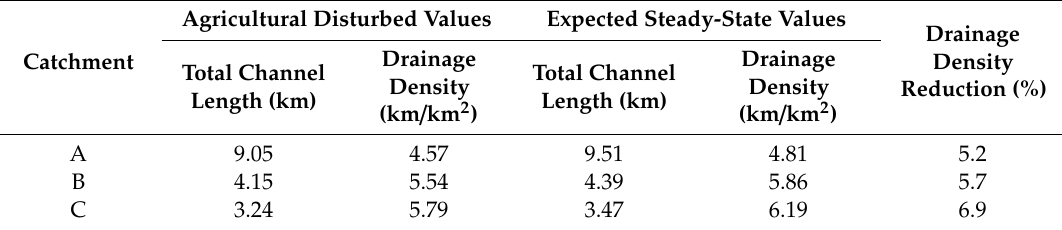
Table 4. E ff ect of agricultural activity on the drainage density values of catchments A, B, and C. Expected steady-state condition values have been obtained by adding the total missing channel length of each catchment to the agricultural disturbed values (the values measured in this study). Total channel length is expressed in km, and the drainage density in km / km 2